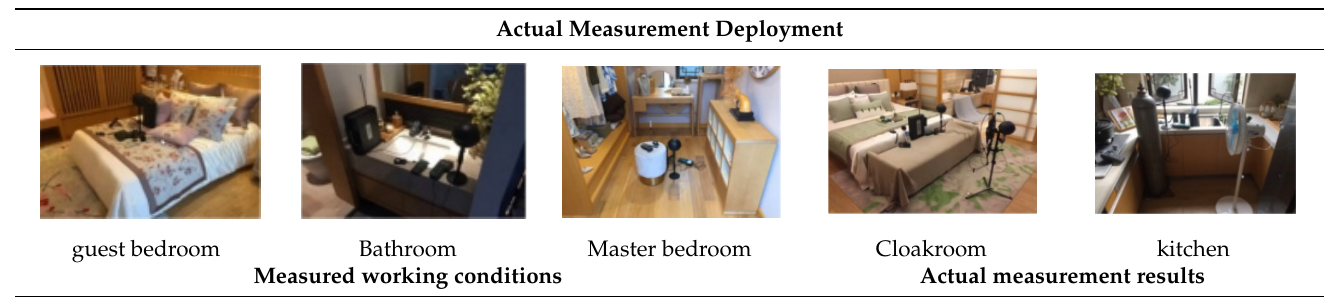
Table 3. Overview of the actual test.